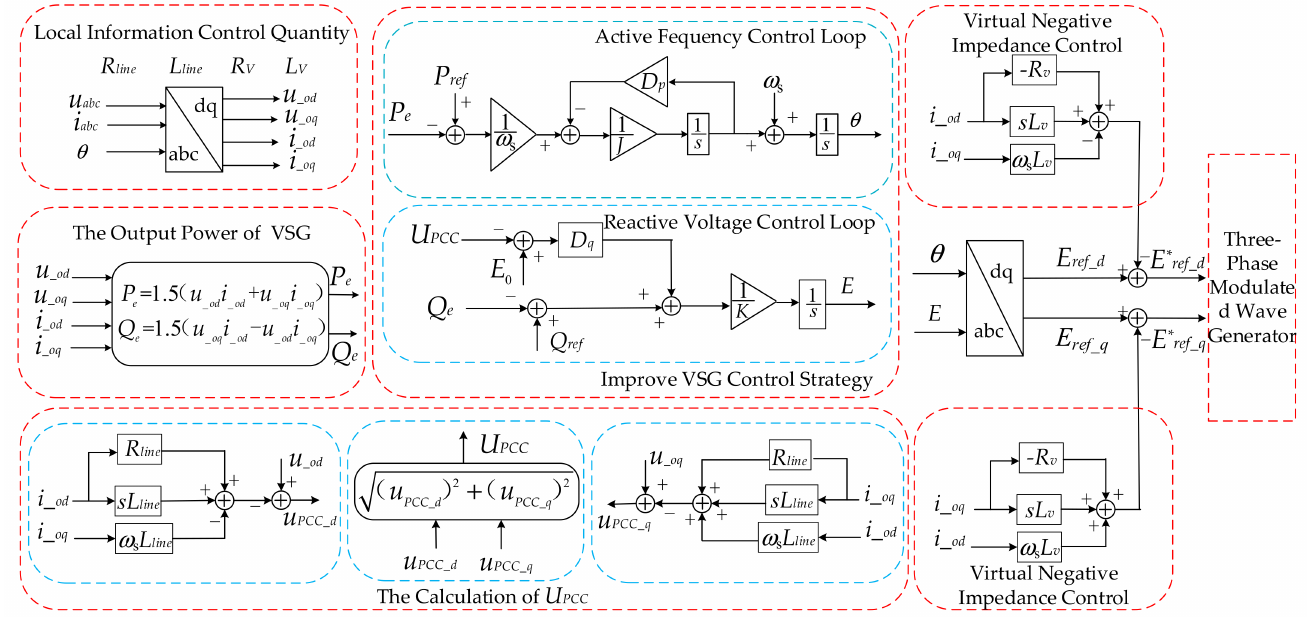
Figure 4. Block diagram of the integrated control